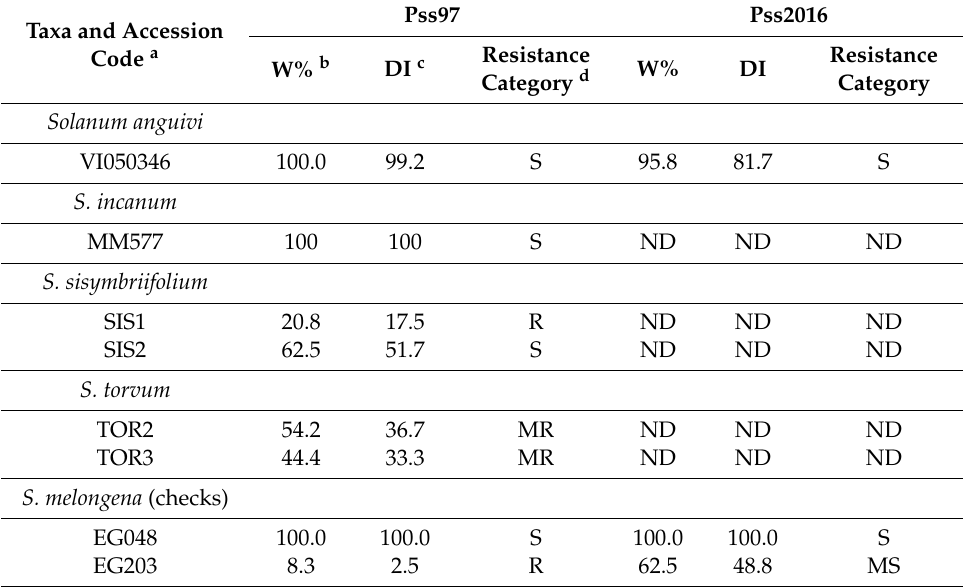
Table 3. Re-evaluation of the resistance of selected resistant and tolerant accessions against Ralstonia solanacearum strains Pss97 and Pss2016 at four weeks after inoculation in the second trial. Pss97 Pss2016 Taxa and Accession Resistance Resistance Code a W% DI W% b DI c Category Category d Solanum anguivi VI050346 100.0